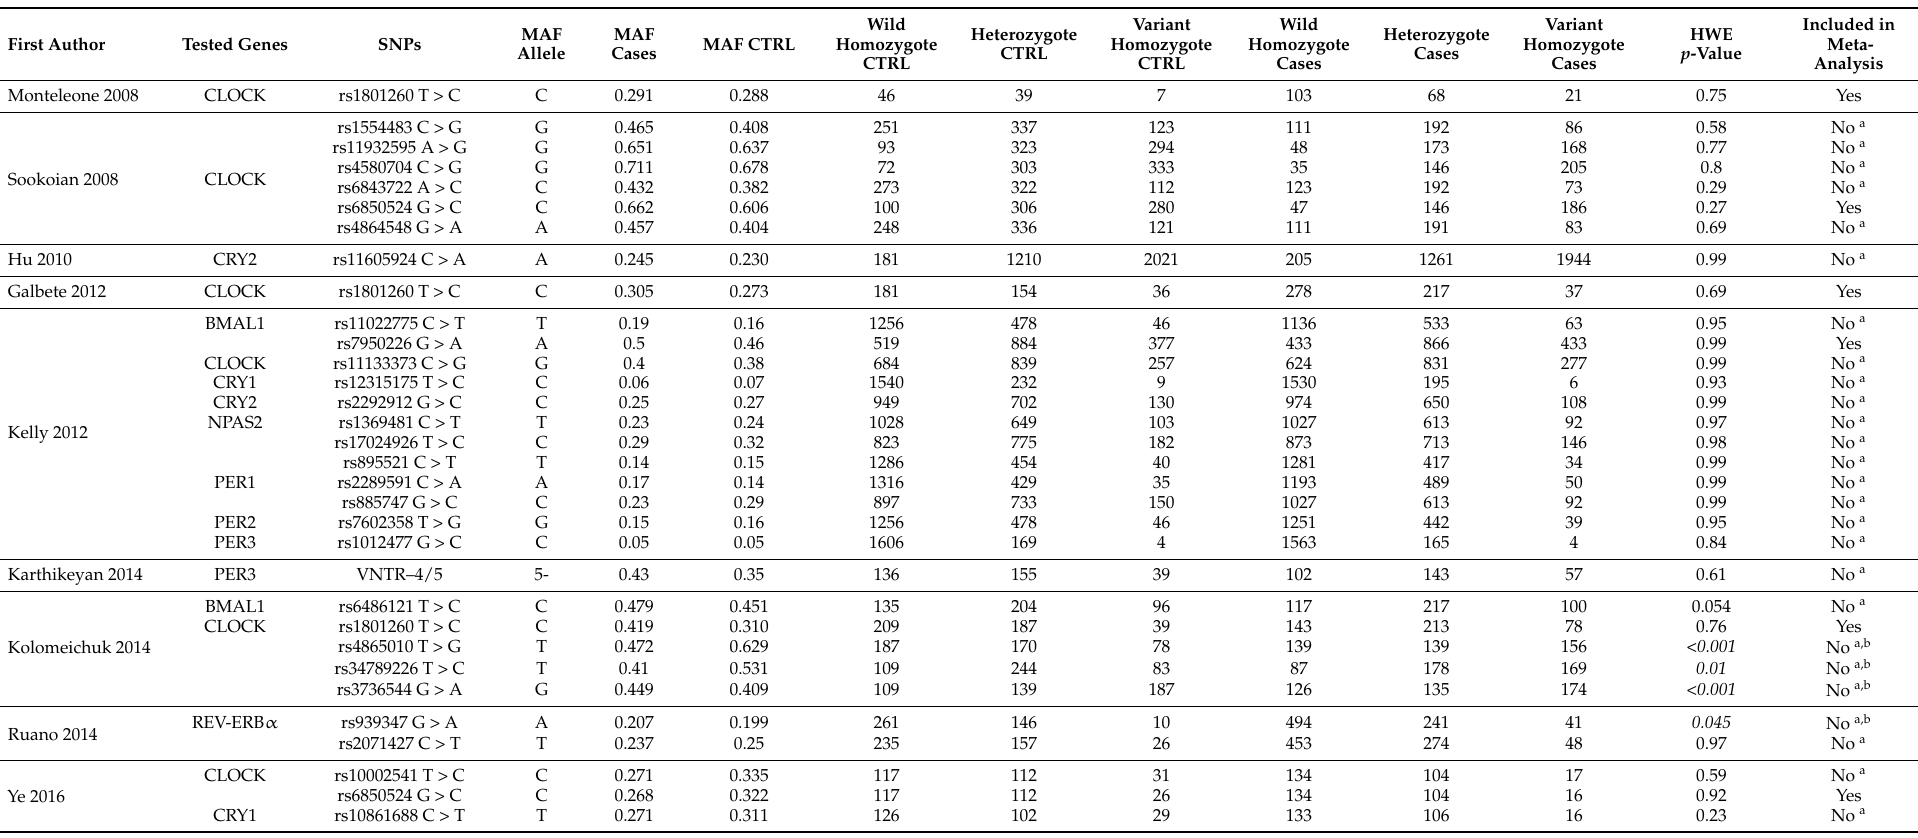
Table 2. Allele and genotype frequency on the circadian rhythm